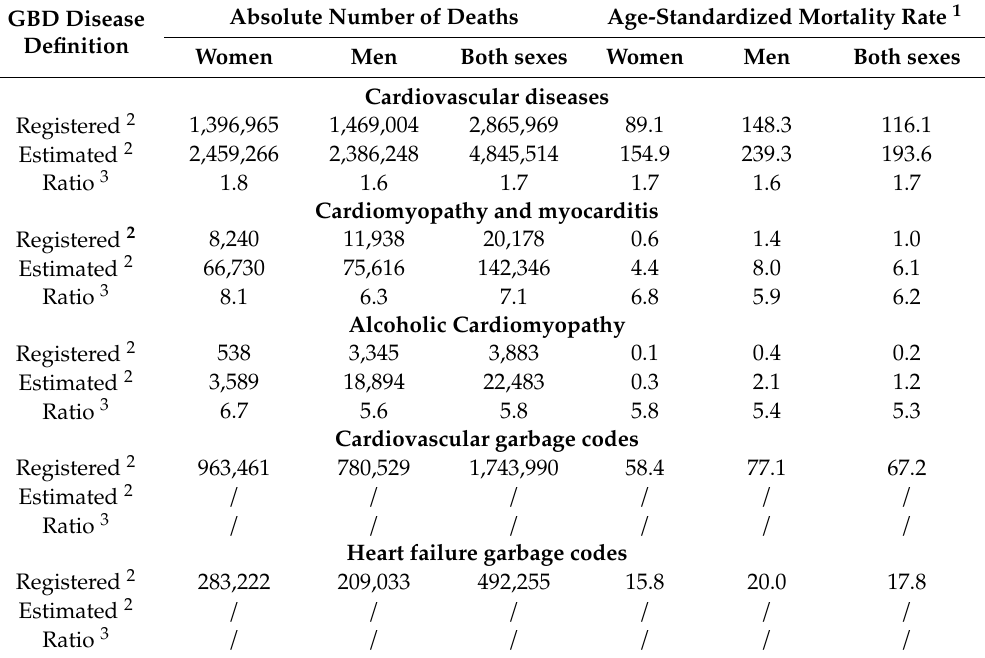
Table 1. Registered and estimated deaths by disease category and